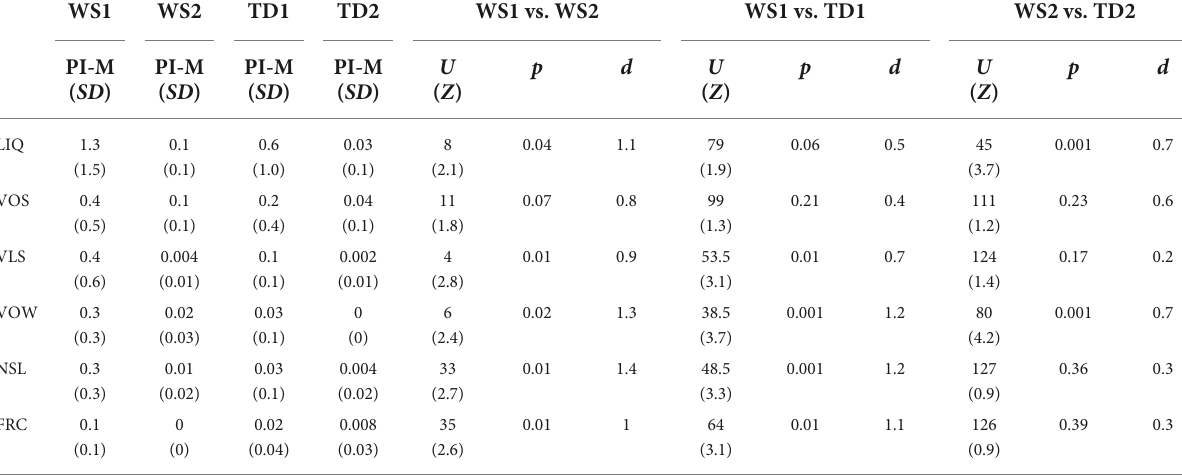
TABLE 5 Omission phonological processes index means and standard deviations for groups, Mann–Whitney U test, and effect size.